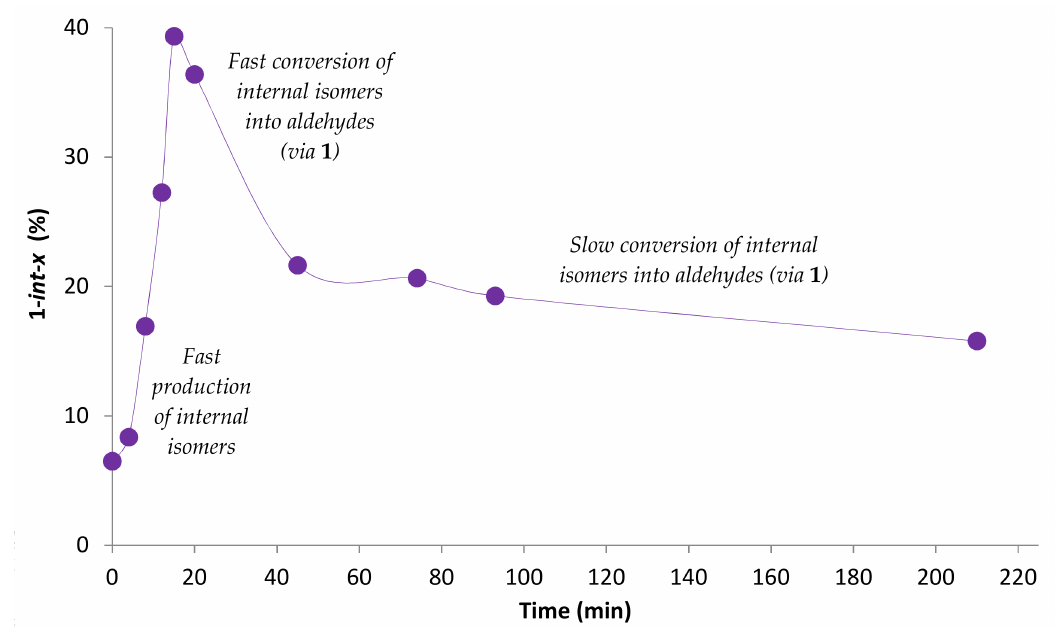
Figure 4. Schematic representation of the “isomerization